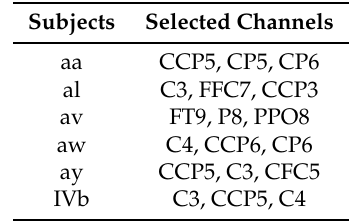
Table 2. List of 3 channels automated